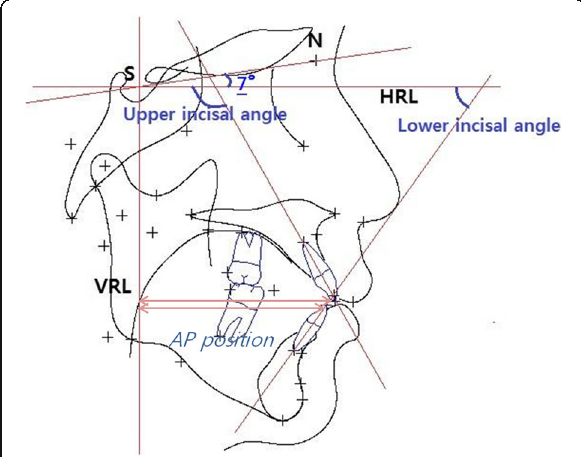
Fig. 2 Landmarks: S: sella, N: nasion, U: upper incisor tip, L: lower incisor tip, VRL, HRL, incisor angle, AP position. Horizontal reference line (HRL): a line drawn 7° clockwise from the sella-nasion line with sella as the center. Vertical reference line (VRL): a line perpendicular to the HRL through the sella. Tooth length: distance from upper or lower incisor tip to apex. Incisal angle: an angle between U1 or L1 line (line through with tip and apex of central upper incisor) with HRL. AP position: distance from upper or lower incisor tip to VRL